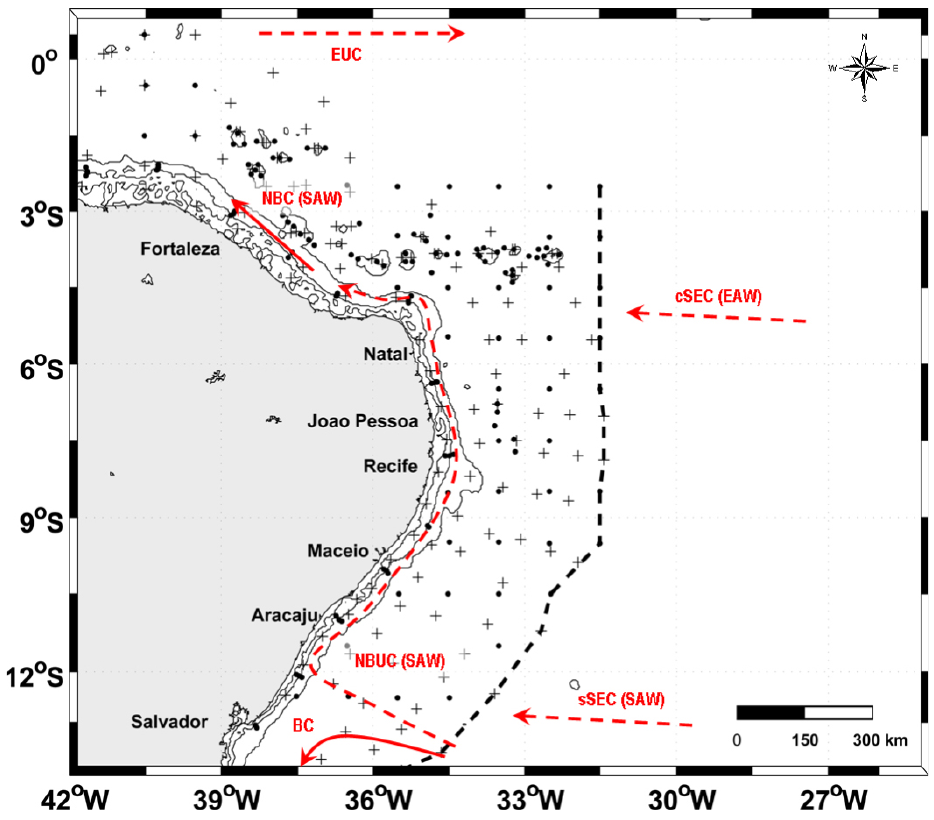
Fig. 1. Area of study with indication of the 20m, 100m and 2000m isobaths. (a) Dots and crosses indicate, respectively, CTD stations during late austral winter (August–October 1995) and austral summer (January–April 1997). Black dashed lines indicate the limited area along which salinity and water mass origins were investigated (T/S diagrams). The schematic surface (subsurface) currents are repre- sented in red solid (dashed) arrows: NBC = North Brazil Current; EUC = Equatorial Undercurrent; NBUC = North Brazil Undercurrent; c/sSEC = central/southern branch of the South Equatorial Current; BC = Brazil